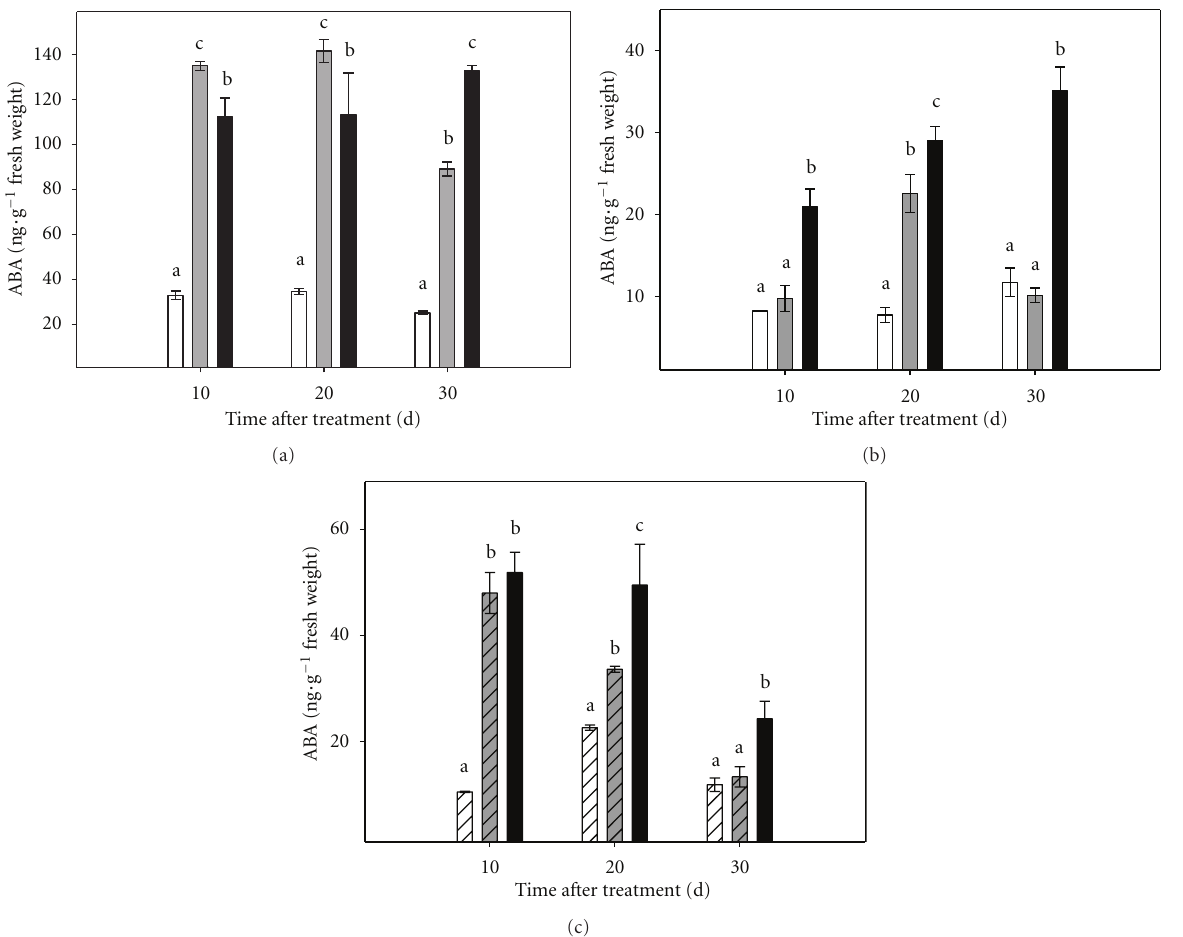
Figure 8: E ff ect of osmotic stress on ABA content in Carrizo citrange plants cultured in vitro . (a): aerial part of intact plants; (b): root tissue of intact plants; (c): micropropagated shoots. Control plants (white bar), plants cultured under moderate (grey bar) or severe (black bar) osmotic stress conditions. Each point corresponds to the average ± standard error of six independent determinations. Di ff erent letters denote statistical significance at P <